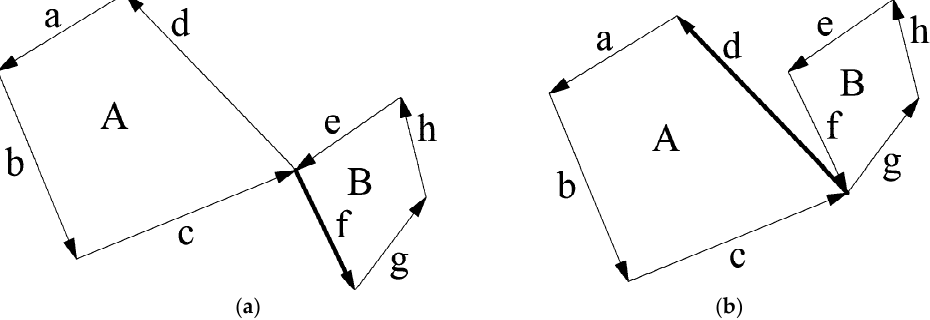
Figure 5. Method of recognizing the potential translation vector; ( a ) Derived from edge f ; ( b ) Derived from edge d .